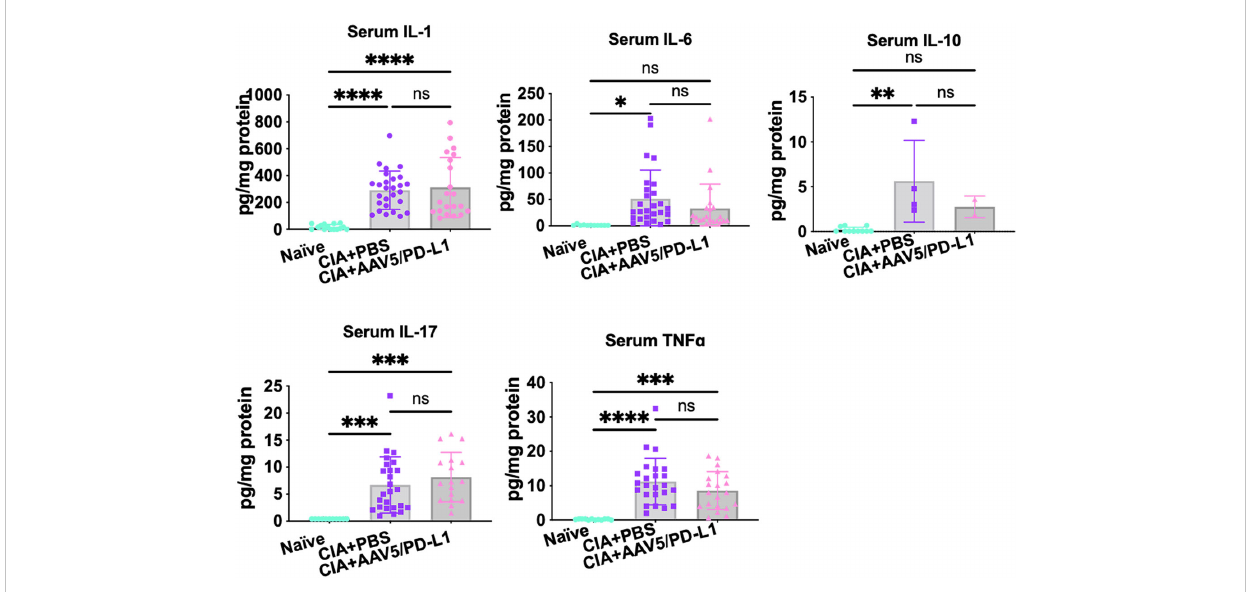
FIGURE 8 The levels of multiple cytokines in mouse serum. Mouse sera were collected from both CIA mice that had been injected with or without AAV5/PD- L1. The concentrations for IL-1, IL-6, IL17A, TNF a , and IL-10 were measured. The mean values are shown with standard derivations. *P < 0.05, **P <